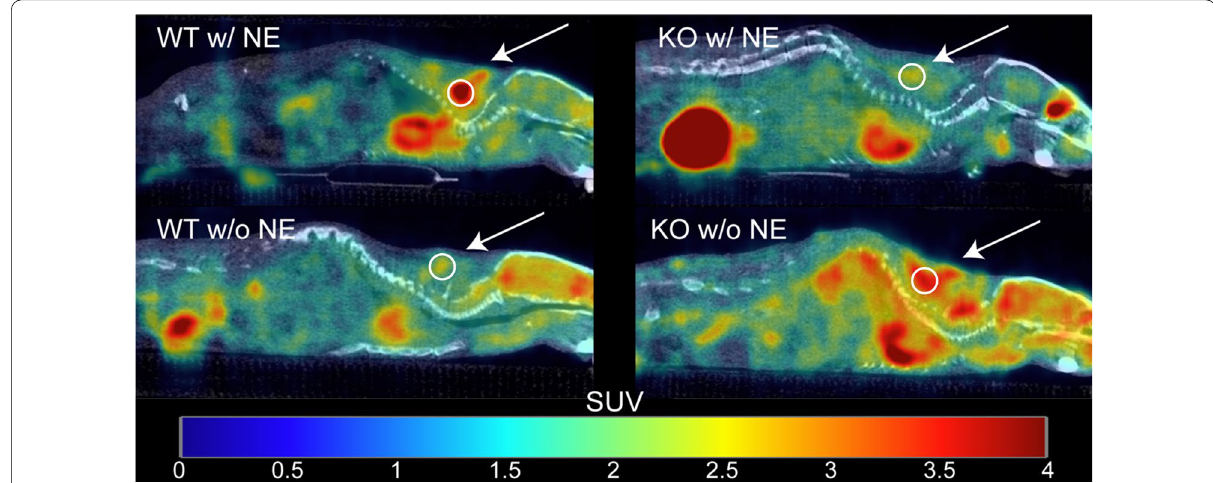
Fig. 5 Example of fused [ 18 F]FDG PET/CT images acquired from fasted male WT and KO mice with and without NE injection. Images are displayed on the same SUV scale on a sagittal view. Male mice from Set 2 were subject to scans with (top row) and without (bottom row) NE injection. The arrows indicate regions of interscapular BAT, and circles indicate the 5 mm 2 ROI centered around the local maximum that was used to measure SUV peak . While uptake increases after NE injection for the WT mouse (left column), uptake for the KO mouse (right column) seems suppressed upon NE injection